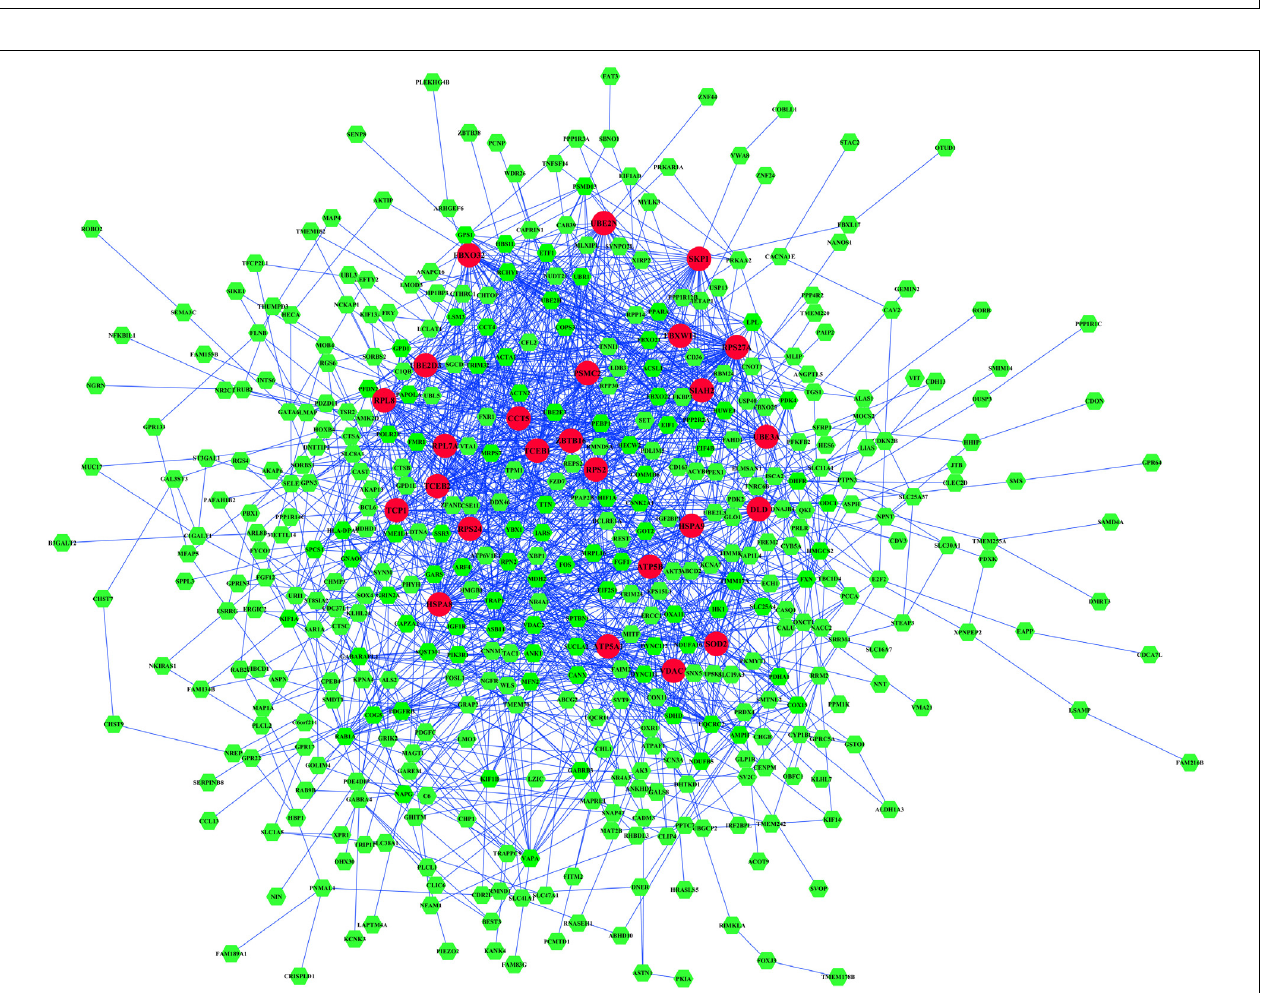
FIGURE 2 | The protein–protein interaction (PPI) network of differentially expressed genes (DEmRNAs). Larger circles with red colors represent hub genes, and smaller hexagons with green colors represent non-hub genes.